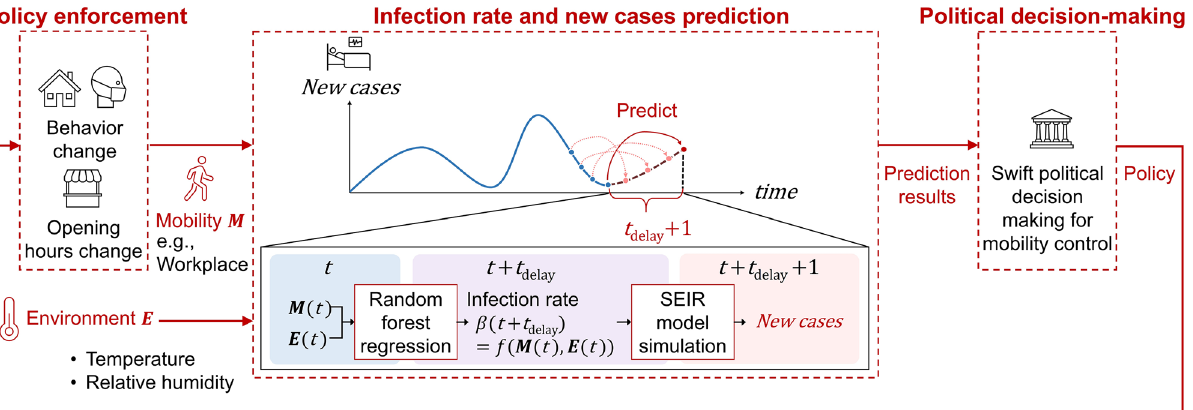
Figure 1. Representation of our modelling approach and predictions. The model comprises two parts. The first part is observed infection rate β ( t ) forecasting. The infection rate β ( t ) is predicted using mobility, temperature, and relative humidity as training data and inputs to the random forest regression. Assuming a time delay between the input measurement day and the day of the change in infection rate β ( t ), the model can be used to forecast the appearance of new COVID-19 cases. The second part is new case forecasting. The number of new cases can be simulated using the predicted infection rate β ( t ) as the input parameter in the SEIR